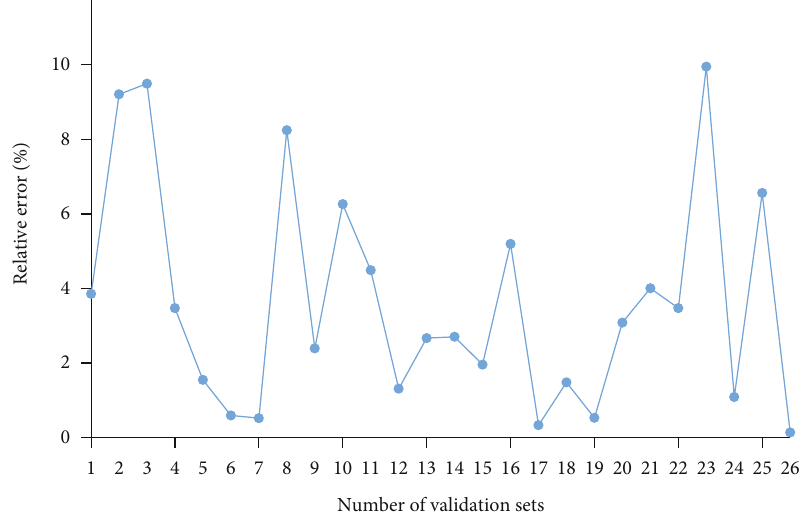
Figure 10: Comparison of relative error between veri fi cation set and